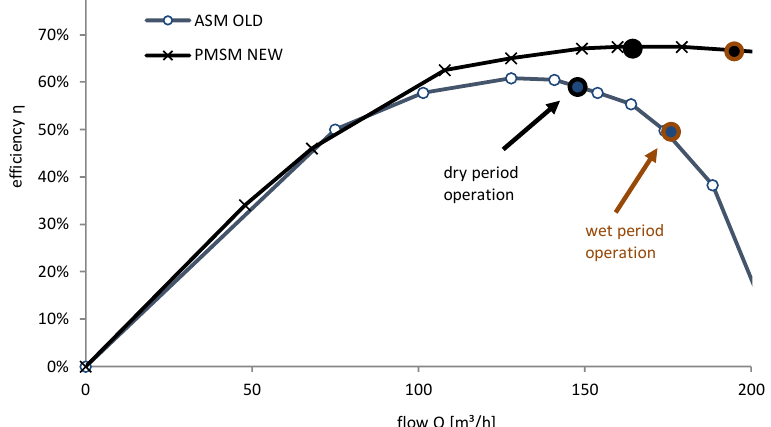
Figure 6. Global efficiency curves for the ASM and PMSM pumps vs flow and individual working points at dry period and wet period operation.